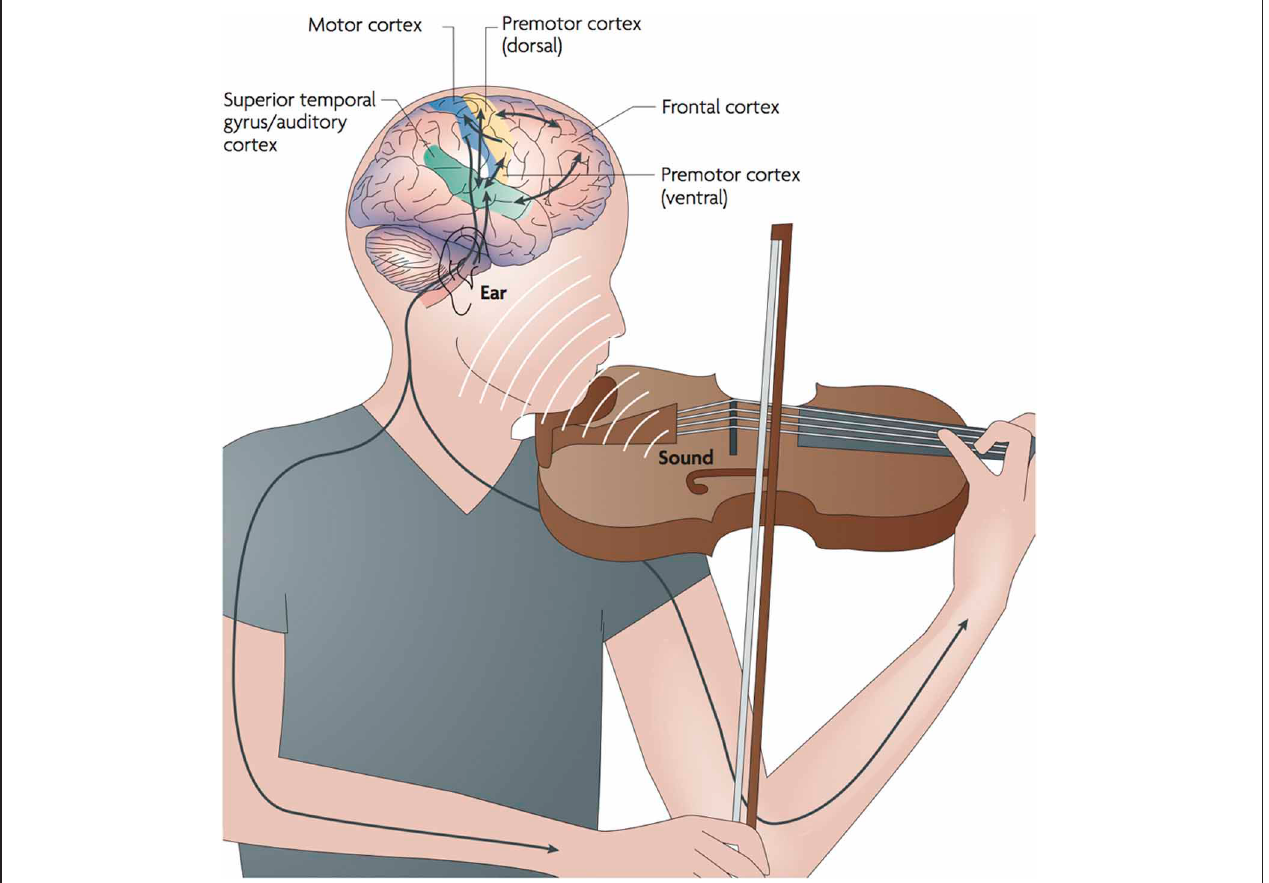
effect. Output signals from premotor cortices are also thought to influence responses within the auditory cortex, even in the absence of sound, or prior to sound; conversely, motor representations are thought to be active on hearing sound, even in the absence of movement. There is, therefore, a tight linkage between sensory and production